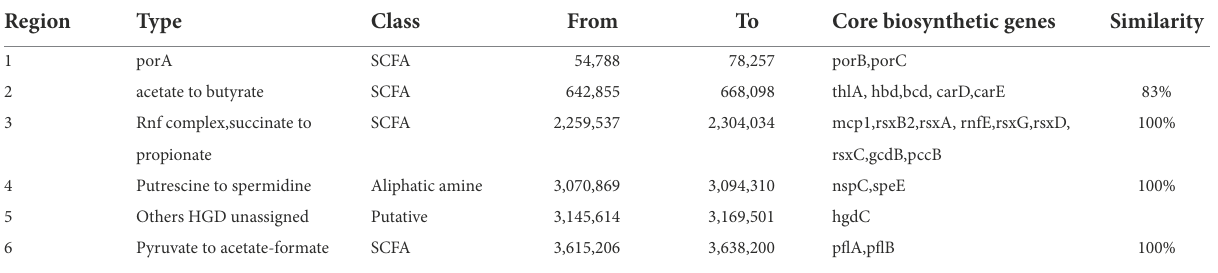
TABLE 2 Identified primary metabolite regions by